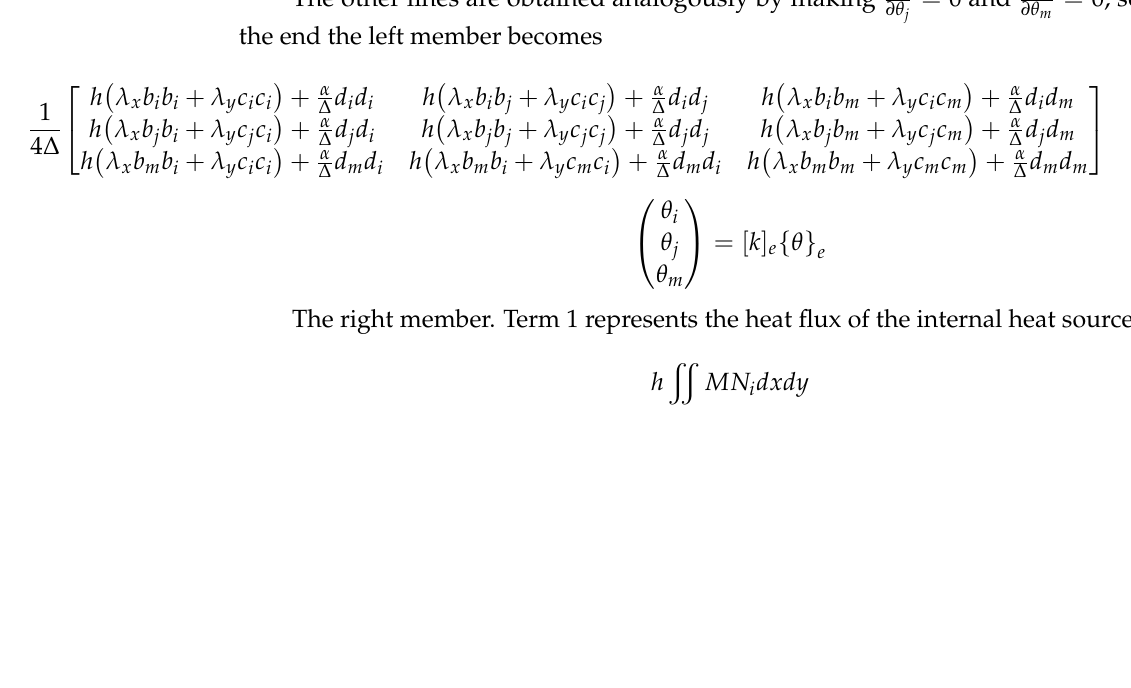
 = 0 and  = 0 , so that in = 0 and ∂ J = 0, so that in     ∂θ j ∂θ m